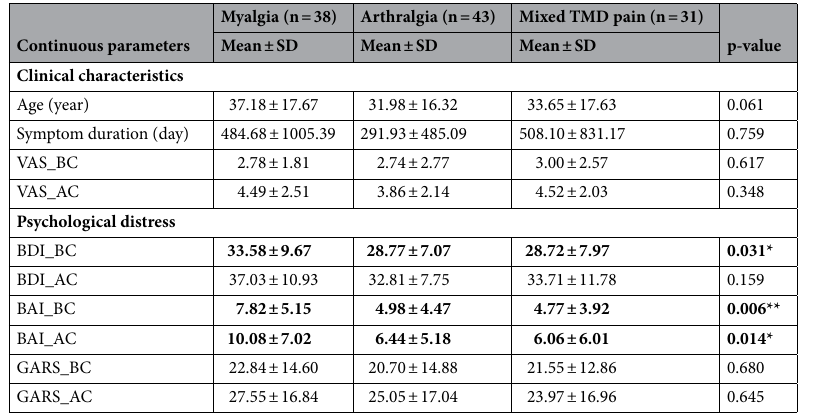
Table 1. Comparison of continuous parameters before and after COVID-19. The mean difference between groups was determined using ANOVA with Tukey’s post hoc test. The p-value significance was set at p < 0.05. *p-value < 0.05, **p-value < 0.01. TMD, temporomandibular disorder; BDI, Beck Depression Inventory; BAI, Beck Anxiety Inventory; GARS, Global Assessment of Recent Stress; BC: before COVID-19, AC: after COVID- 19, _BC, total score in BC; AC, total score in AC. Significant results were bolded.